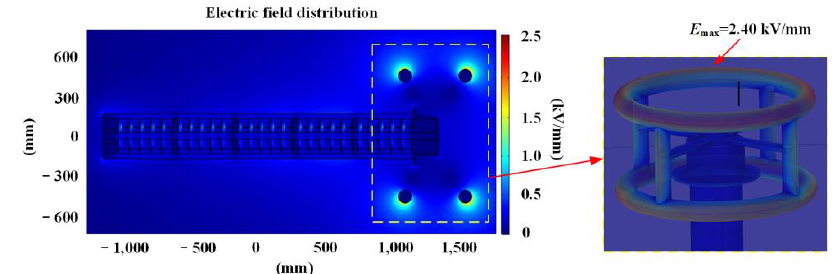
Figure 3. Electric field distribution of the high–voltage arm.